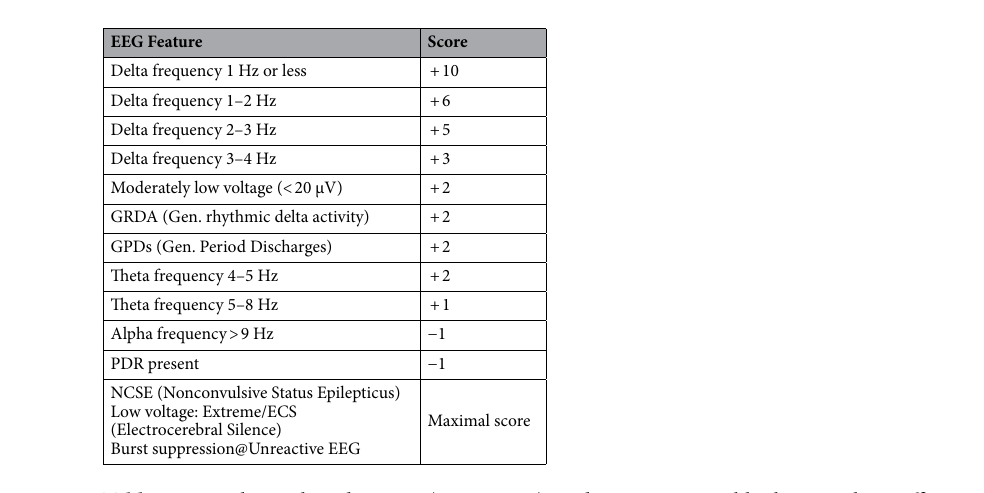
Table 3. Visual EEG-based ICANS (VE-ICANS) grading system. A table showing the coefficients for each feature in the VE-ICANS model. A patient’s VE-ICANS score is the sum of all features present in their EEG. Positive scores indicate a feature with a positive correlation to ICANS severity. Features with the highest values are the most significant features in grading ICANS severity and contribute the most to the VE-ICANS